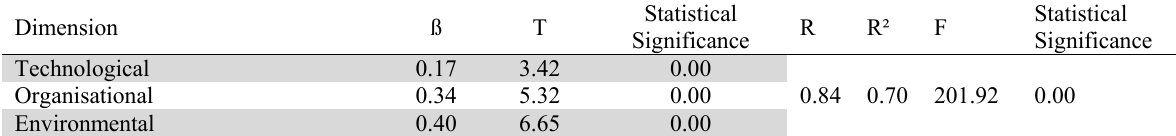
Results of Applying the Multiple Regression Equation to Study the Impact of Adopting E-Collaboration Tools on Knowledge Management Processes Dimension